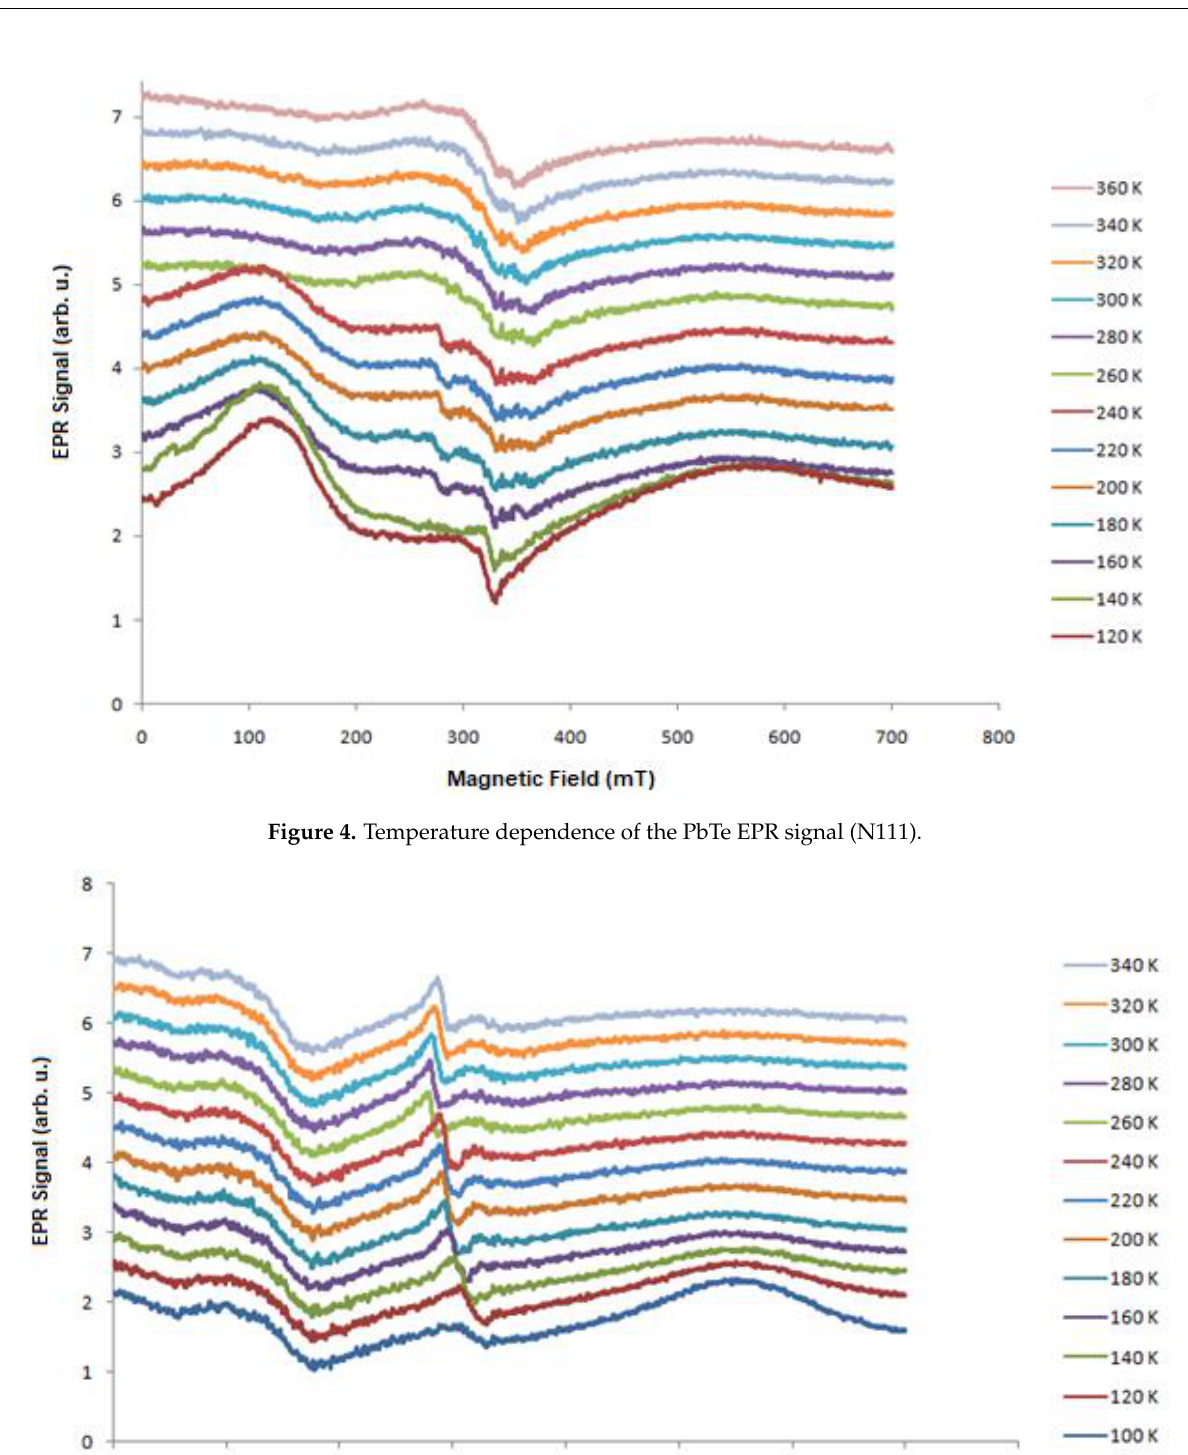
Figure 5. Temperature dependence of the EPR signal of PbTe:In (N151).